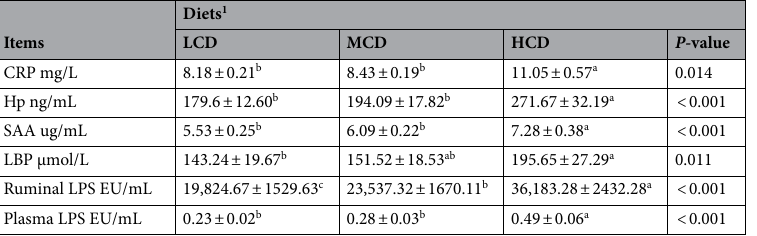
Table 4. Effect of different dietary levels of concentrate on blood parameters in Angus cows. CRP = C-reactive protein; Hp = haptoglobin; SAA = serum amyloid A; LBP = LPS-binding protein; ruminal LPS = lipopolysaccharide in ruminal fluid; plasma LPS = plasma lipopolysaccharide; a,b,c Means bearing different superscripts in the same row differ significantly ( P < 0.05). 1 LCD, 35:65 concentrate:forage; MCD, 50:50